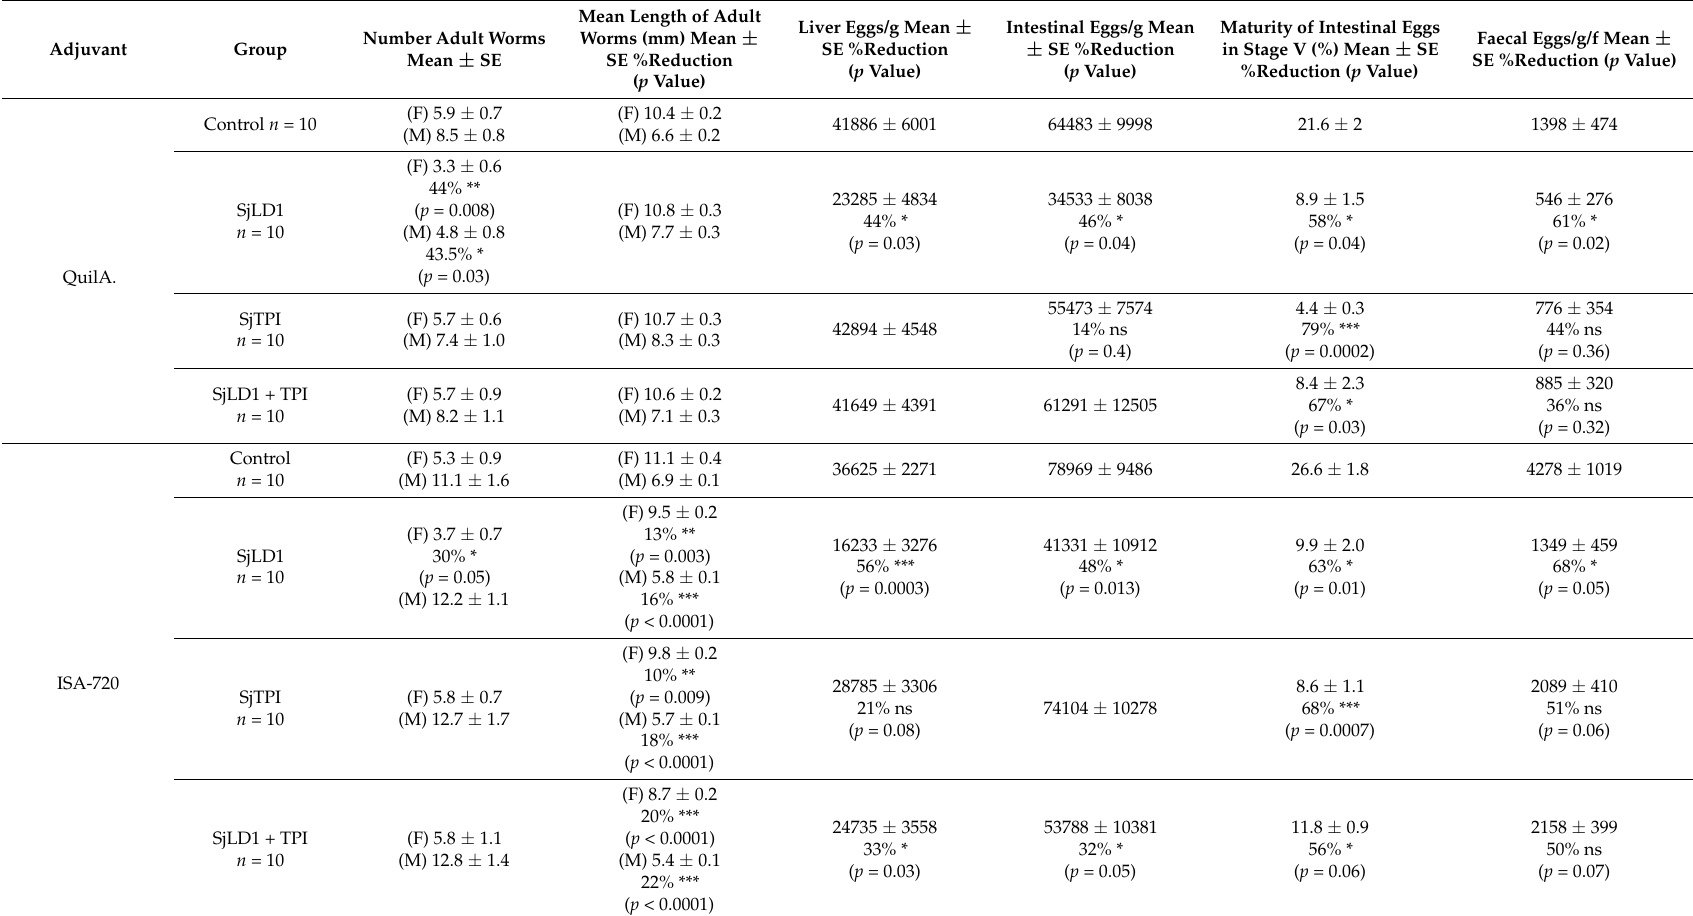
Table 1. Parasitologic data for vaccinated and control mice challenged with 34 ± 1 Schistosoma japonicum